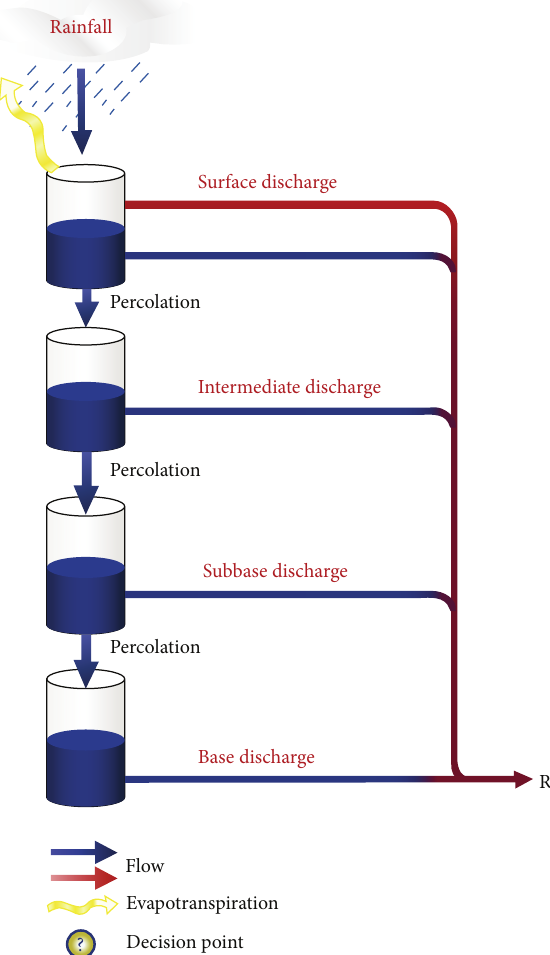
Figure 17: The TANK model structure (Source: RRL